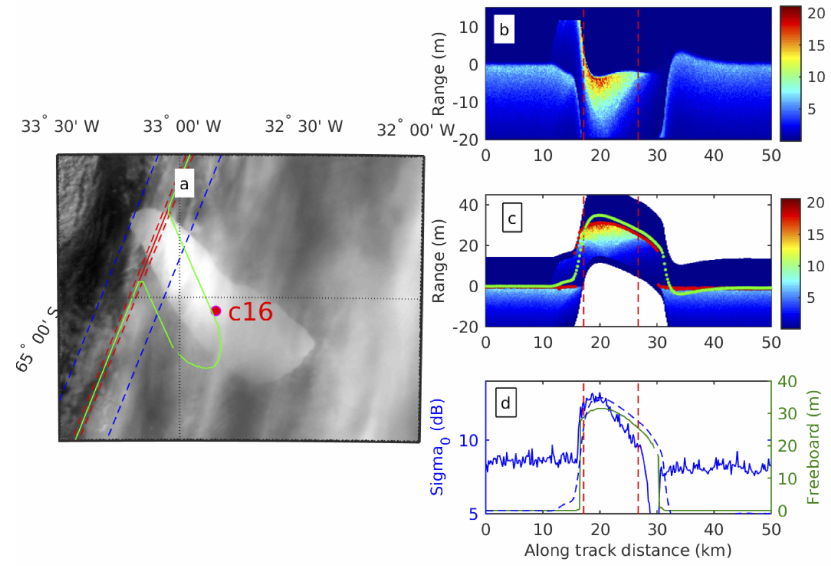
Figure 23. ( a ) MODIS image on 17 March 2013 17:34 UT and SARAL/AltiKa descending pass 102 Cycle 1 (17 March 2013 18:19UT). The red and blue dashed lines indicate the width of the first and last range bins, respectively, and the green line the elevation profile. ( b ) SARAL/AltiKa waveforms over C16. The dashed red lines indicate the iceberg limits from MODIS image. ( c ) Re-tracked waveforms using the tracker position, the green line represents the tracker position and the red line the elevation profile using a dedicated re-tracker. ( d ) Re-tracked elevation profile (green line), tracker position (dashed green line) and measured backscatter (blue line).